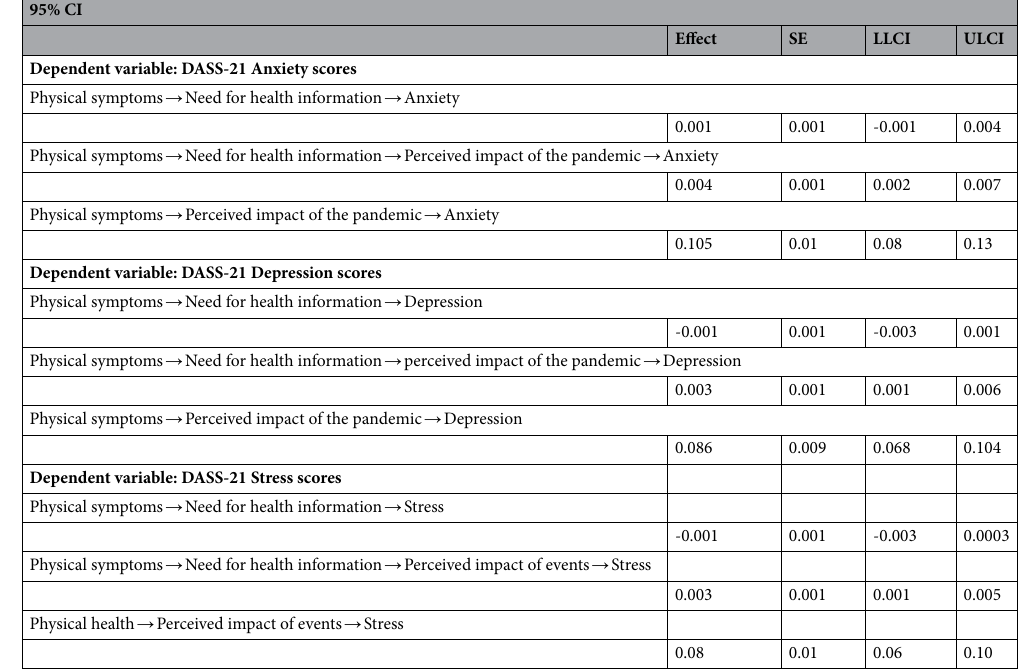
Table 3. Results of the chain mediating effect based on Bootstrapping